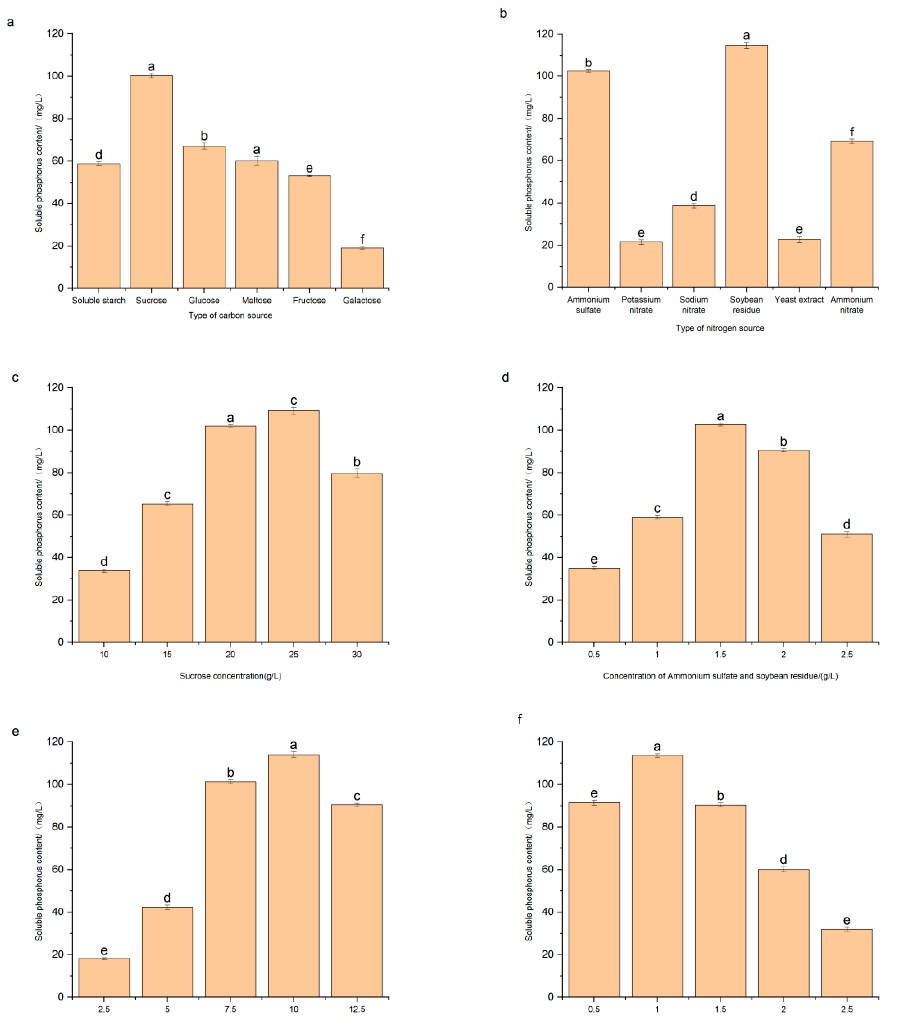
Figure 4. Effect of medium composition on the phosphate-solubilizing capacity of PSF7. ( a ) Types of carbon sources. ( b ) Types of nitrogen source. ( c ) Sucrose concentration. ( d ) Concentration of ammonium sulfate and soybean residue. ( e ) Tricalcium phosphate concentration. ( f ) Inorganic salt concentration.